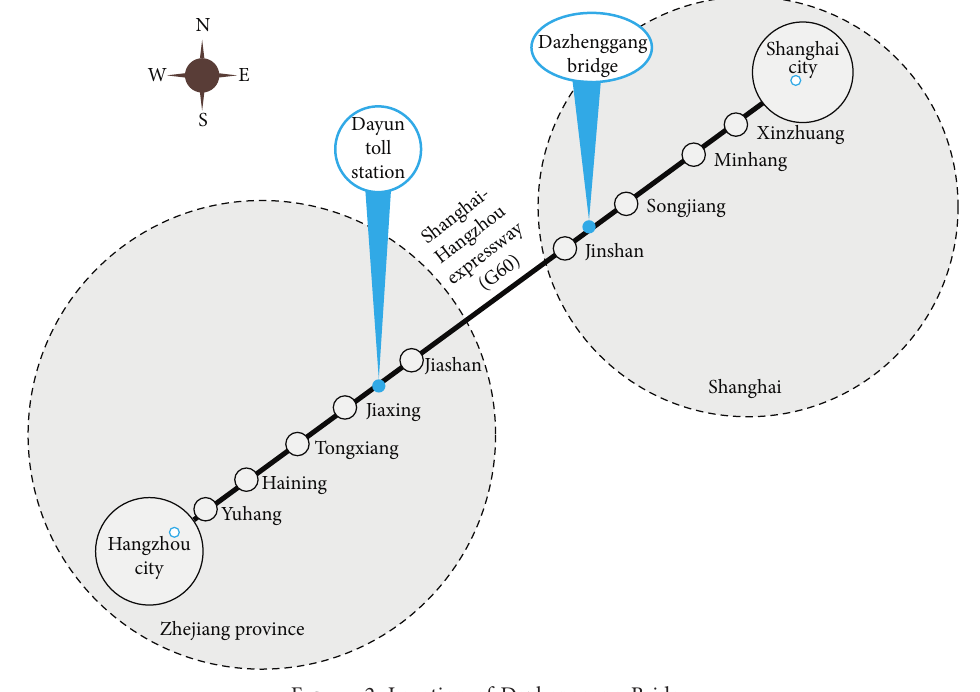
Figure 2: Location of Dazhenggang Bridge. Table 1: Vehicle type classification.